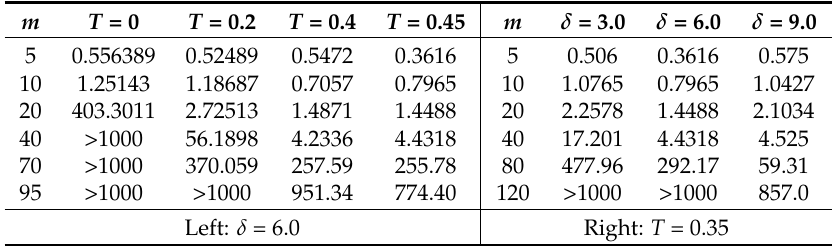
Table 1. Run time of one-resource-one-type SC-M* under different parameters.